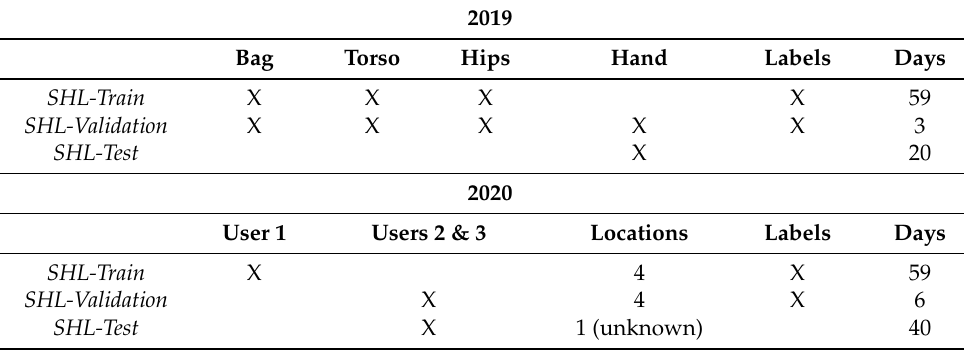
Table 1. Summary of the datasets provided for 2019 and 2020. “X” denotes whether data from that location were present in the subset and whether the subset was